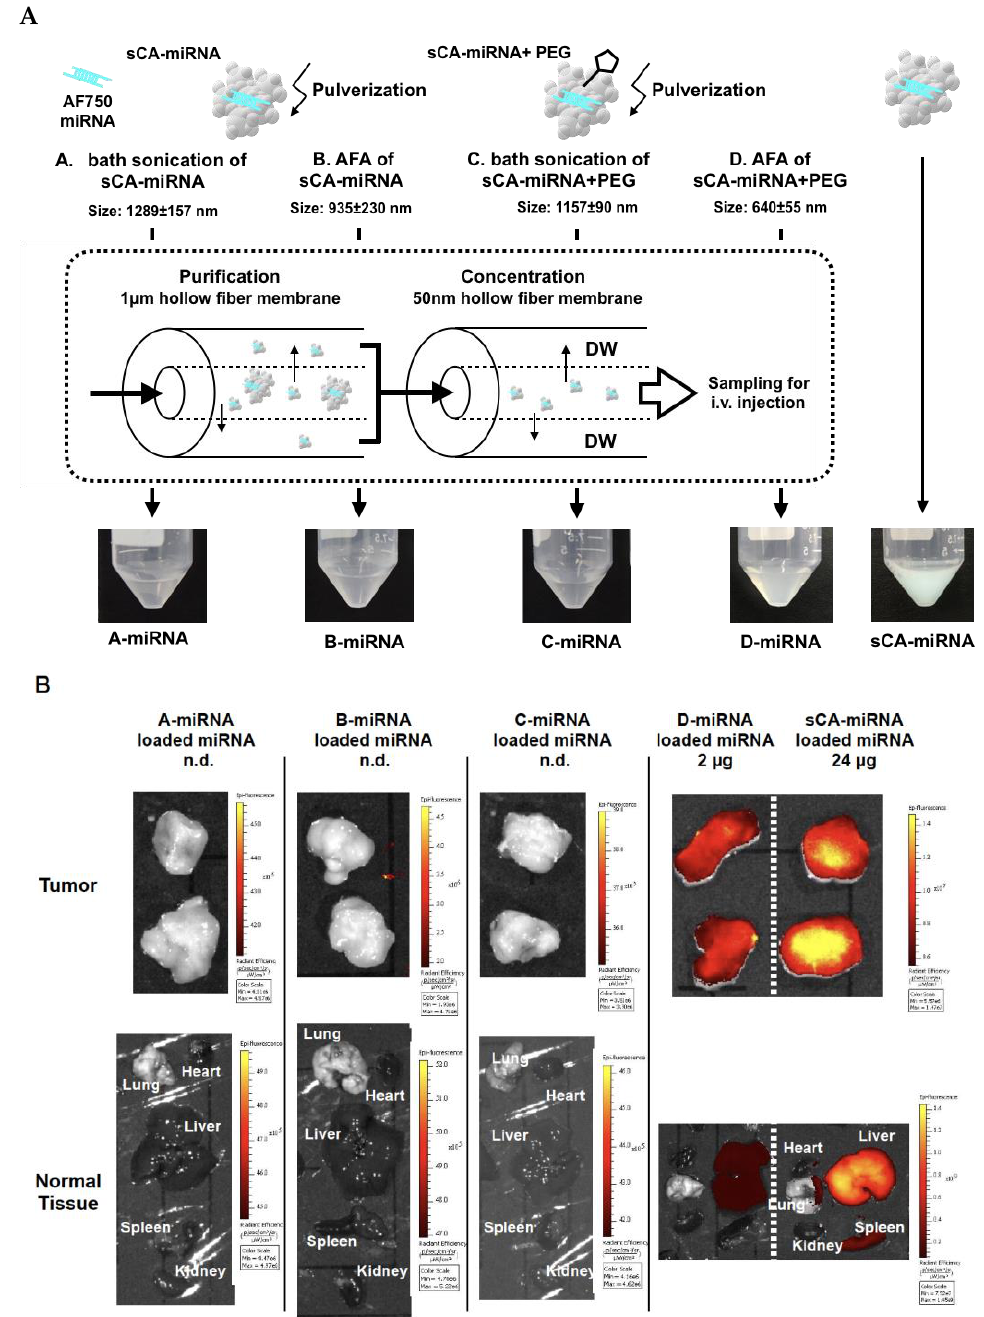
Figure 4. Purification and concentration followed by IVIS imaging. ( A ) The four samples (A: bath sonication of sCA-miRNA, B: AFA of sCA-miRNA, C: bath sonication of sCA-miRNA+PEG, and D: AFA of sCA-miRNA+PEG) were purified and concentrated using the 1 µ m and 50 nm hollow-fiber membranes, resulting in A-miRNA, B-miRNA, C-miRNA, and D-miRNA. A-miRNA, B-miRNA, and C-miRNA looked transparent, whereas D-miRNA was cloudy blue and the sCA-miRNA sample for injection was a deep turquoise blue in color. ( B ) The four processed samples and sCA-miRNA were intravenously injected into mice bearing HT29 tumors. Ex vivo IVIS imaging of tumor and normal tissues (heart, lung, liver, spleen, and kidney) 1 h after the injection. The miRNA on processed samples A-miRNA, B-miRNA, and C-miRNA was not detectable (n.d.). The miRNA loading of D-miRNA was 2 µ g, and that of sCA-miRNA was 24 µ